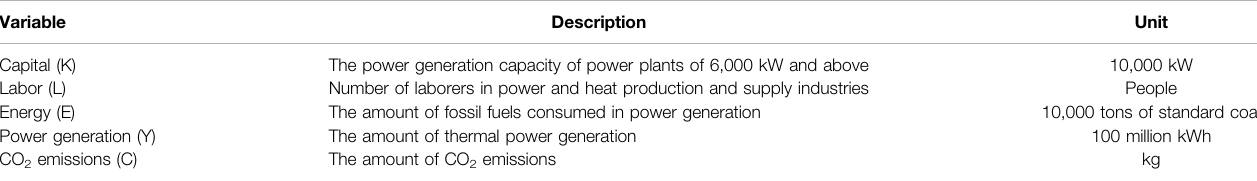
TABLE 1 | Data description for measuring thermal power generation ef fi ciency. Variable